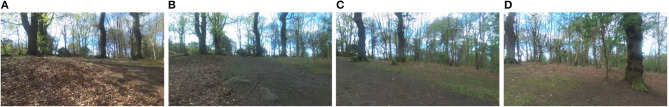
Place matches achieved on Hillwood Bebop dataset demonstrate robustness to rotation [view is shifting right from (A) to (D)], illumination changes [sun passes behind cloud between (A) and (B)] and onset of previously unseen occluding objects [large tree comes into view in foreground between (C) and (D)].